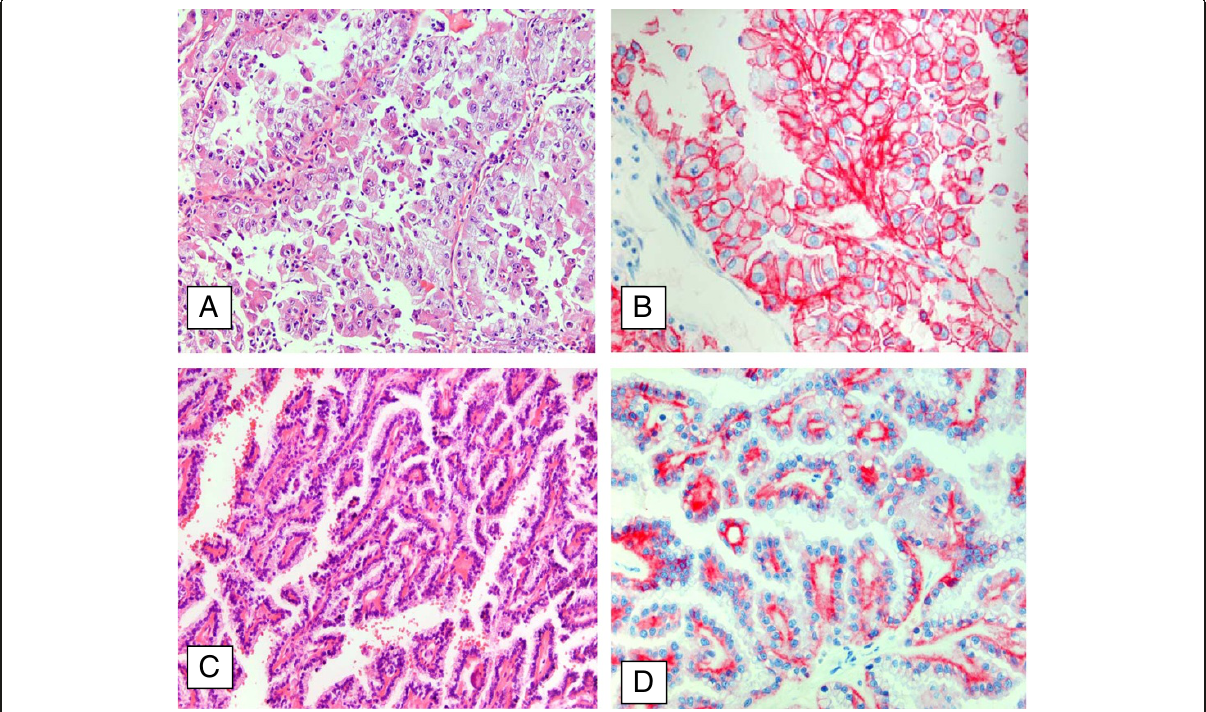
Figure 1 Immunohistochemistry of N-cadherin expression in papillary RCC. Papillary RCC type II with high nuclear polymorphism and abundant cytoplasm of the tumor cells ( A , x20) displays a strong membranous expression of N-cadherin ( B , x40). Papillary RCC type I with a single layer of cuboidal cells and a small cytoplasmic rim ( C , x20) shows only a weak cytoplasmic N-cadherin ( D ,